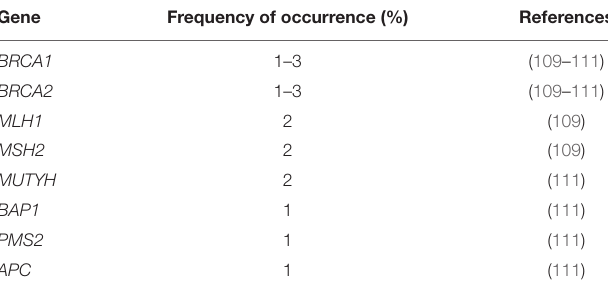
TABLE 1 | Summary of germline mutations reported in intrahepatic